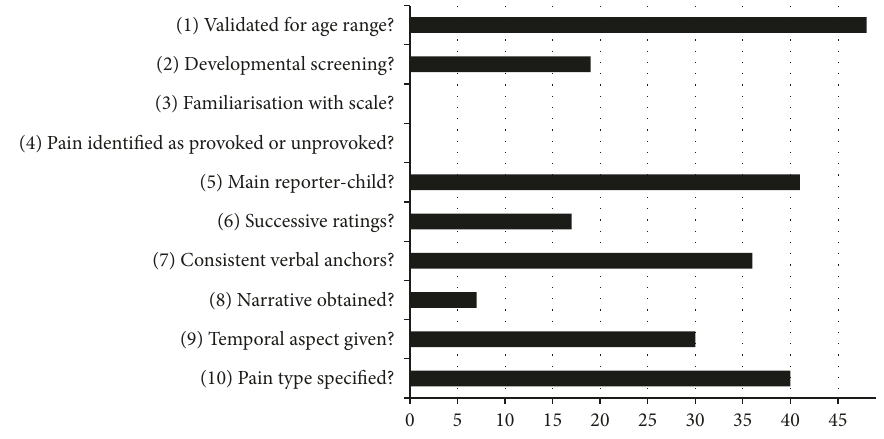
Figure 2: Quality scores against